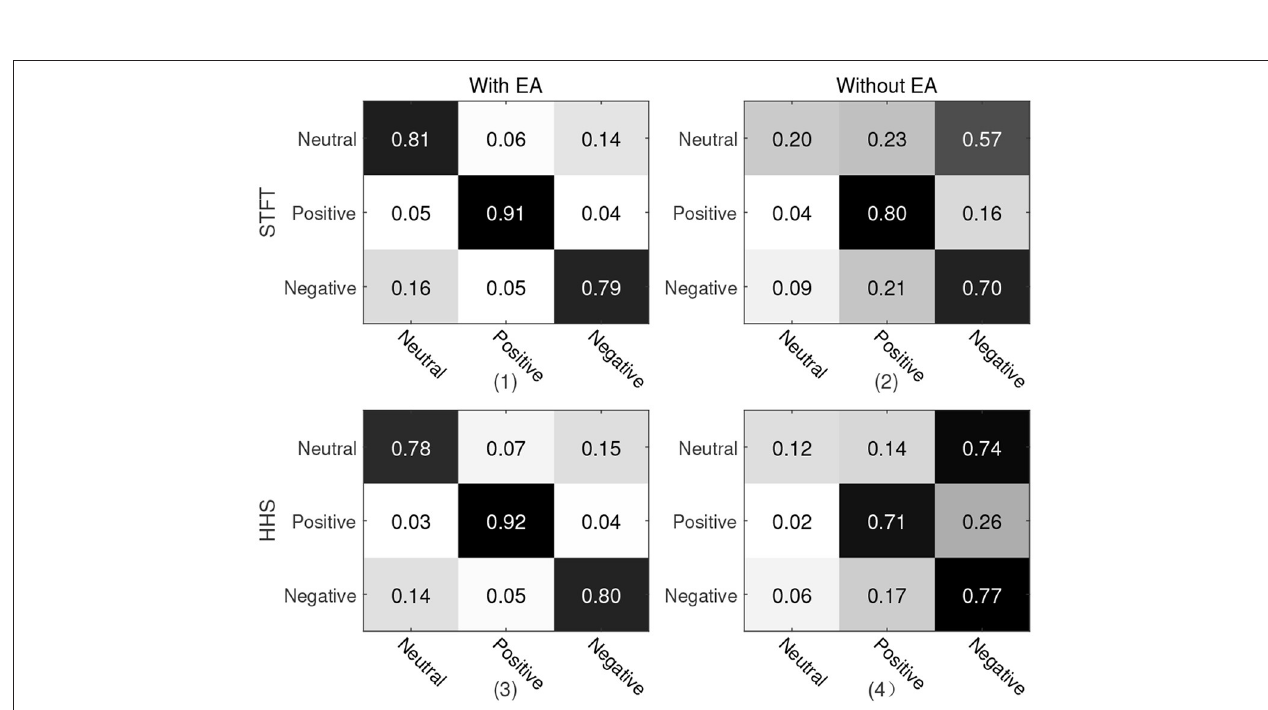
FIGURE 4 | Confusion matrix of protocol 1. The vertical axis is the true label and the horizontal axis is the predicted label. (1) and (2) are the recognition results of STFT features; (3) and (4) are the recognition results of HHS features; (1) and (3) are with Euclidean alignment (EA) module, while (2) and (4) are the recognition result without the EA